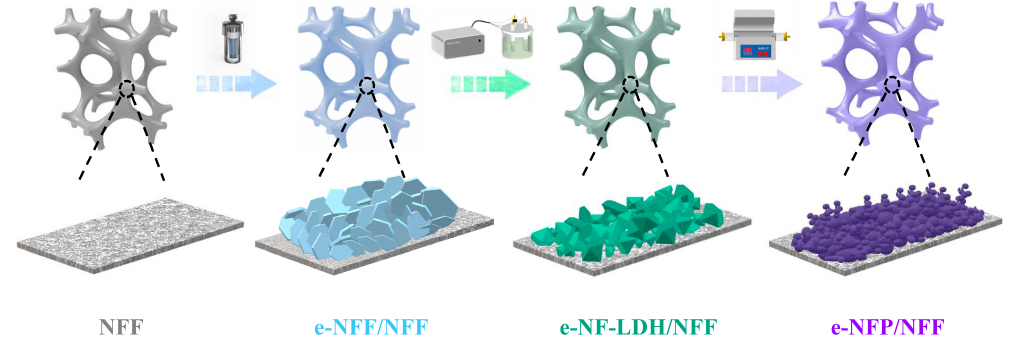
Figure 1. Schematic representation for the synthetic process of e-NFP/NFF electrodes.